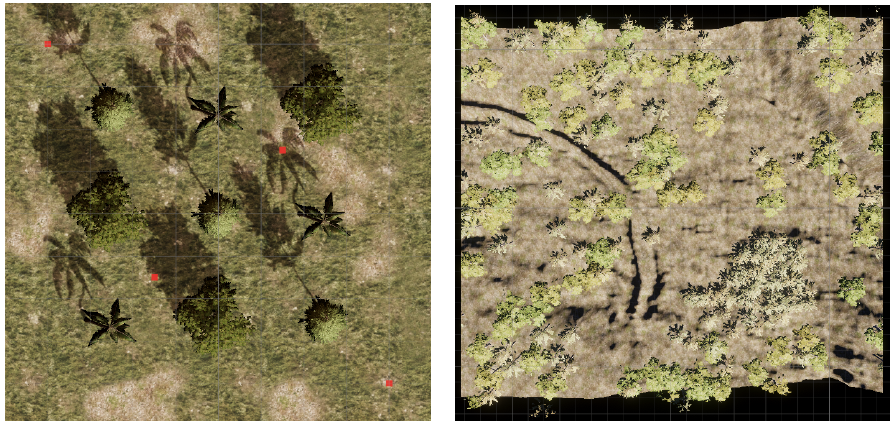
Figure 3. Both synthetic scenarios used in this work: Simple Trees on the ( left ) and Yosemite on the ( right